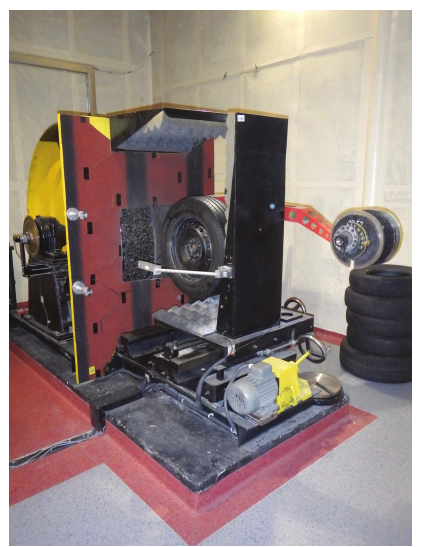
Fig. 4. Roadwheel facility with 1.7m diameter drum at the Technical University of Gdansk,